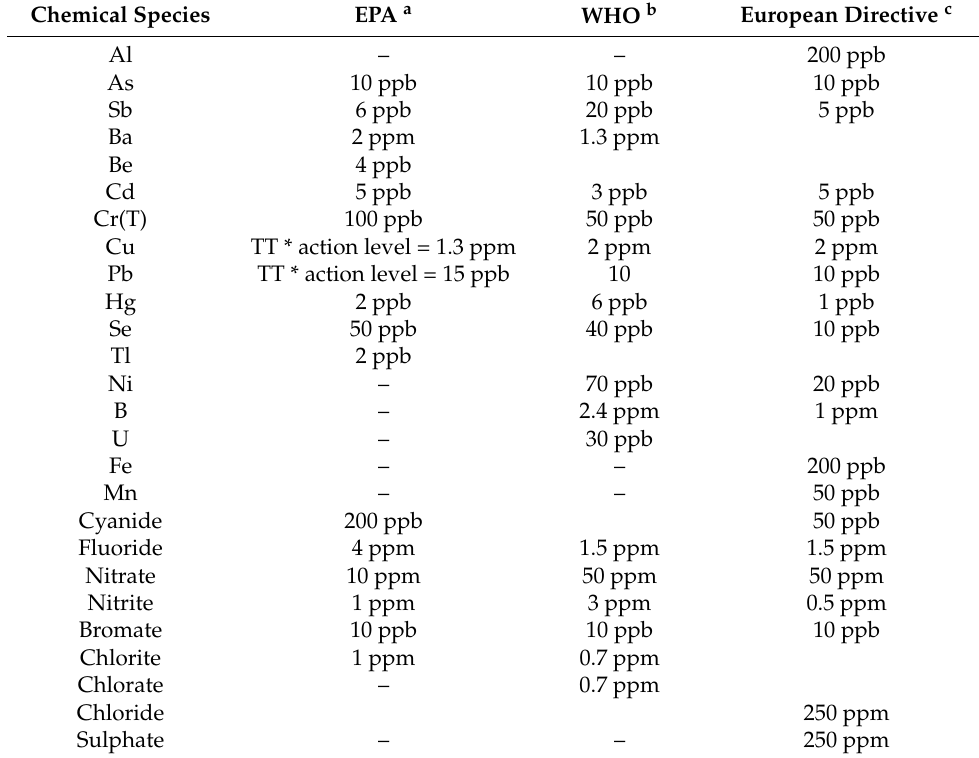
Table 3. Concentration values of metal ions and anionic species regulated by EPA, WHO, and European Directive in drinking